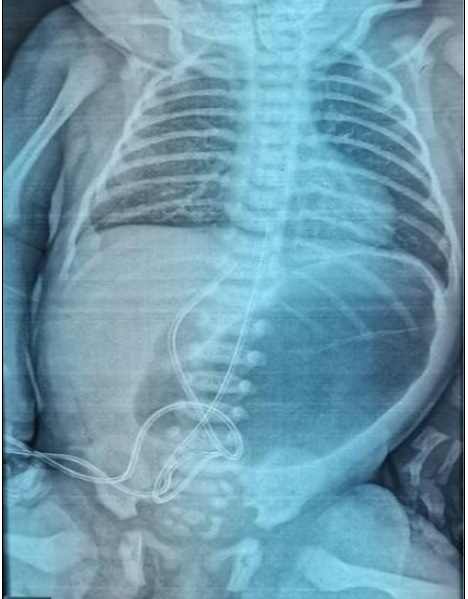
Figure 1: Infantogram showing Coiling of NG tube in the upper thorax and dilated stomach and duodenal cap with no distal